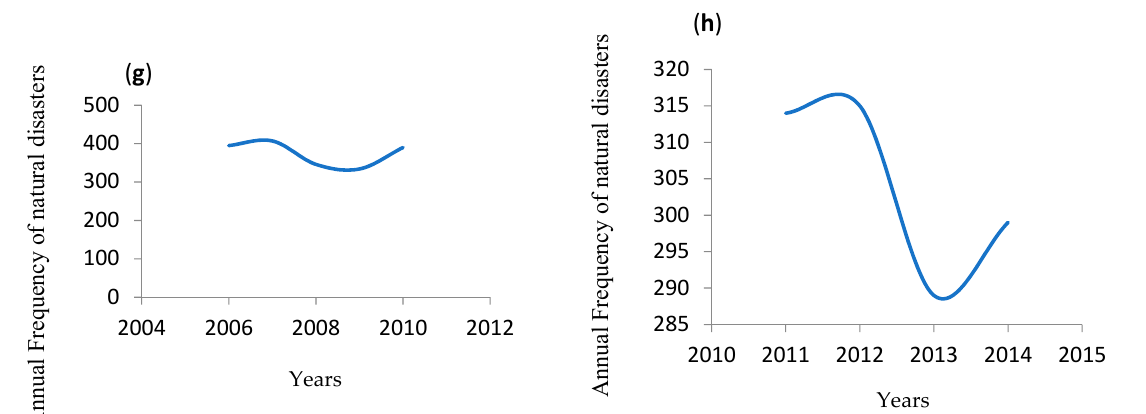
Figure 1. Average Cycle Period is shown in above figures (source: Author created based on International Disaster Database—Centre for Research on the Epidemiology of Disasters). Note: In the above figures; ( a – h ) authors show annual frequency of natural disasters on y axis. Years are plotted on X axis. In this figure author showed that average period for one complete cycle is nearly five years.